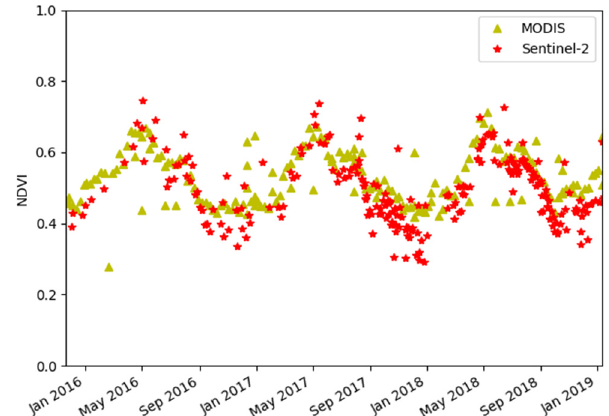
Figure 3. NDVI computed from MODIS and Sentinel-2 data over a 3-year period for the 31TCJ tile (near to Toulouse, in southwestern France).